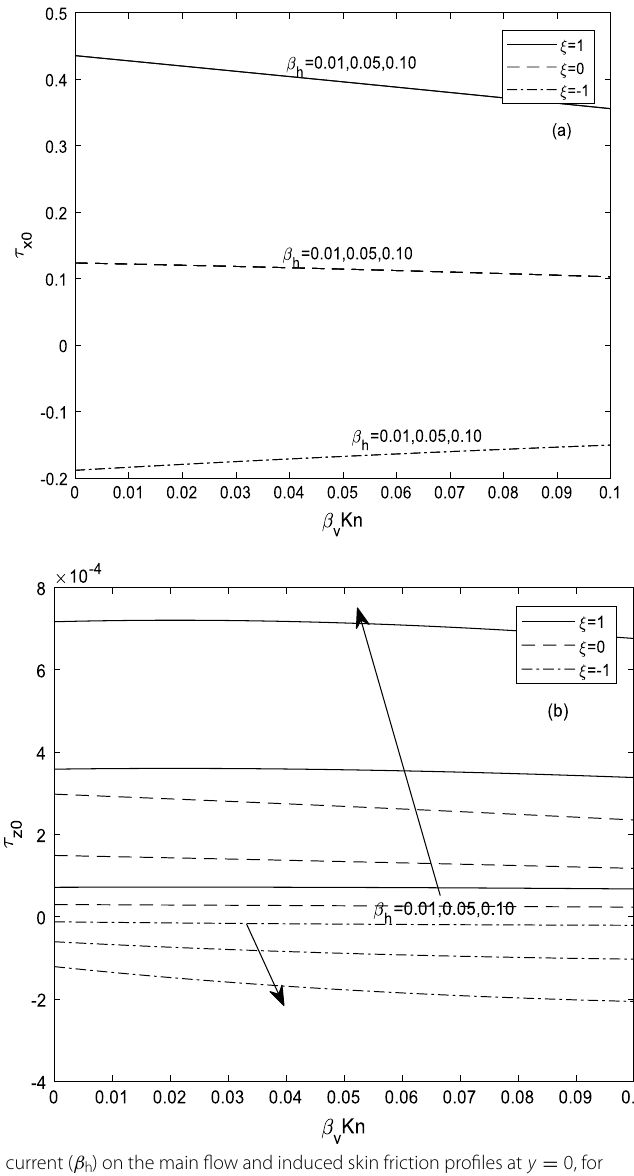
Fig. 10 a Hall current ( β h ) on the main flow and induced skin friction profiles at y = 0 , for β v Kn = 0.05, M = 2,ln = 1.667, M = 2.0, β i = 3.0 and Pr = 0.71 . b Hall current ( β h ) on the main flow and induced skin friction profiles at y = 0 , for β v Kn = 0.05, M = 2,ln = 1.667, M = 2.0, β i = 3.0 and Pr =